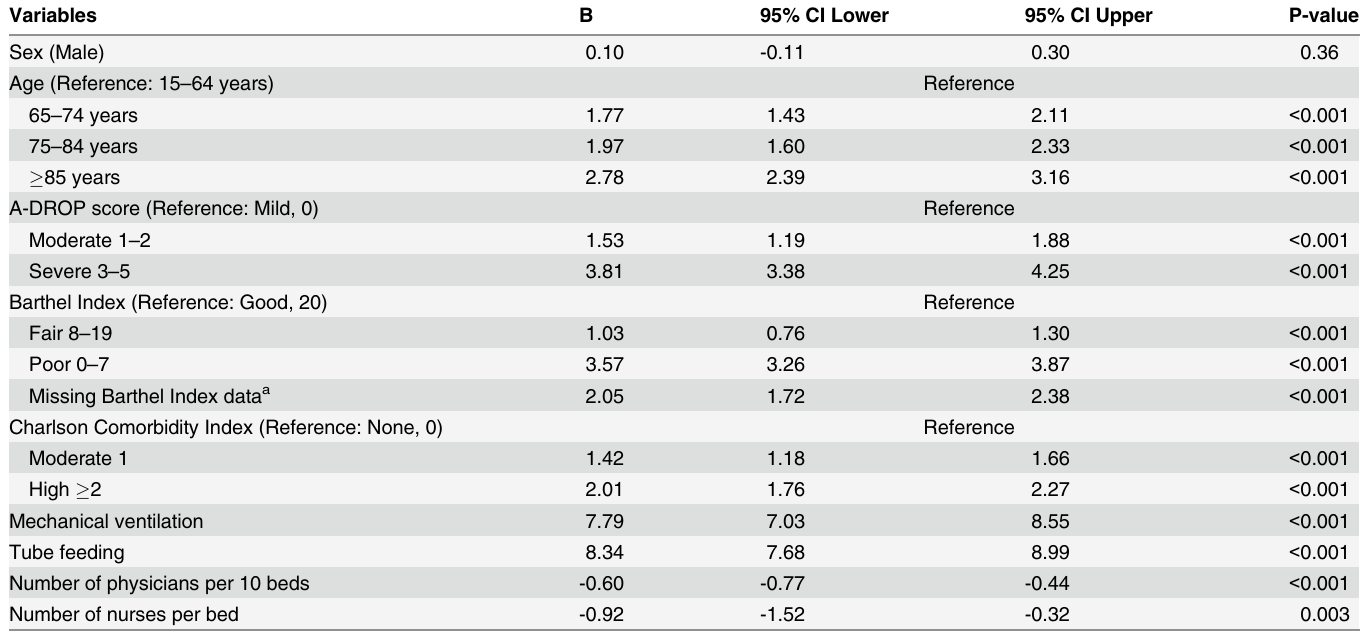
Table 2. Direct effects of the factors on length of stay using a structural equation model (n =